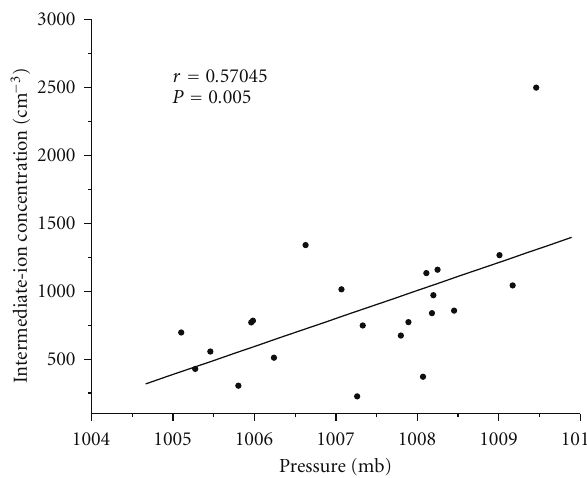
Figure 9: Scattered diagram of daily averaged intermediate-ion concentration and daily averaged sea surface pressure with line of best